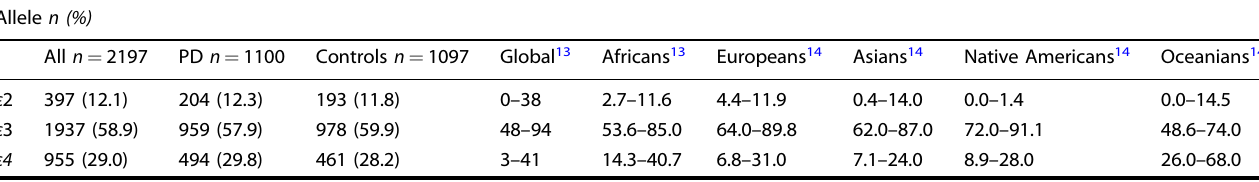
Table 1. APOE allele distribution in Nigerians with PD and controls in comparison to other normal global and ethnic populations. Allele n (%) All n =